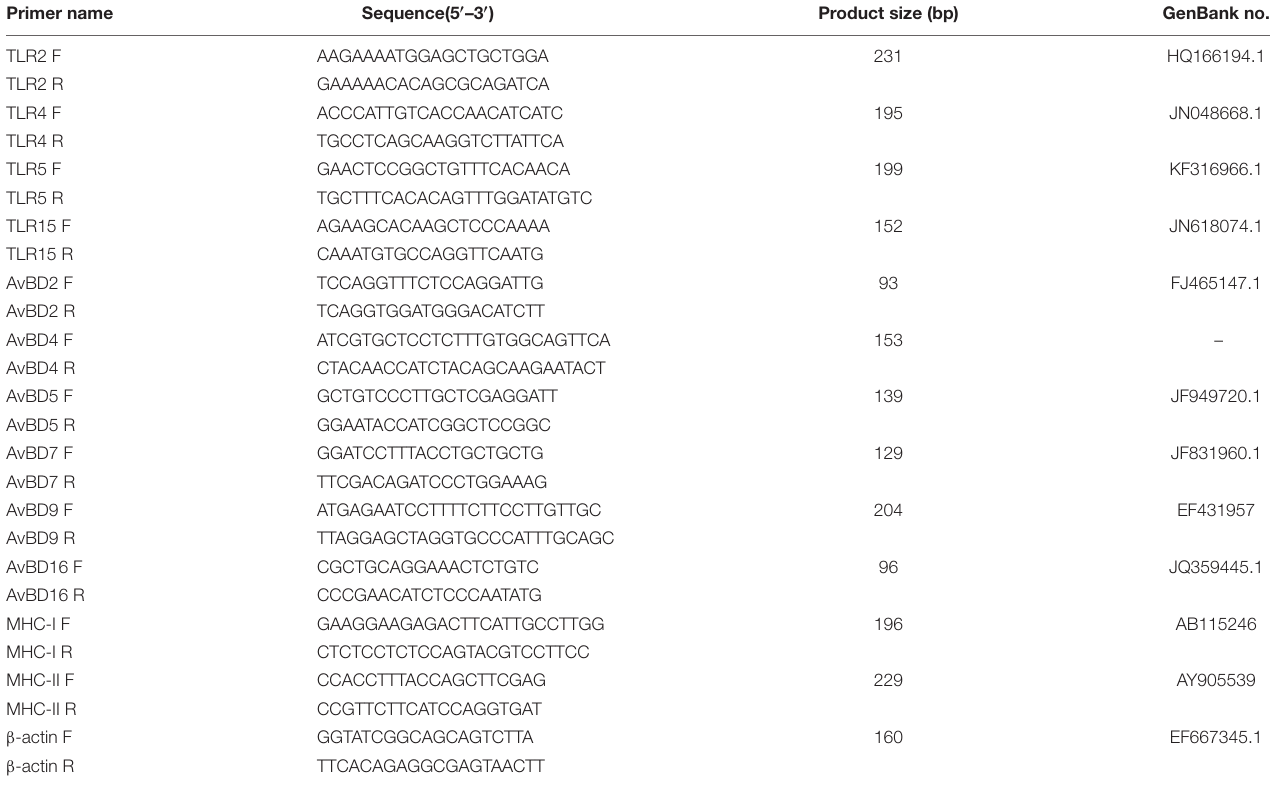
TABLE 1 | Primers used in this